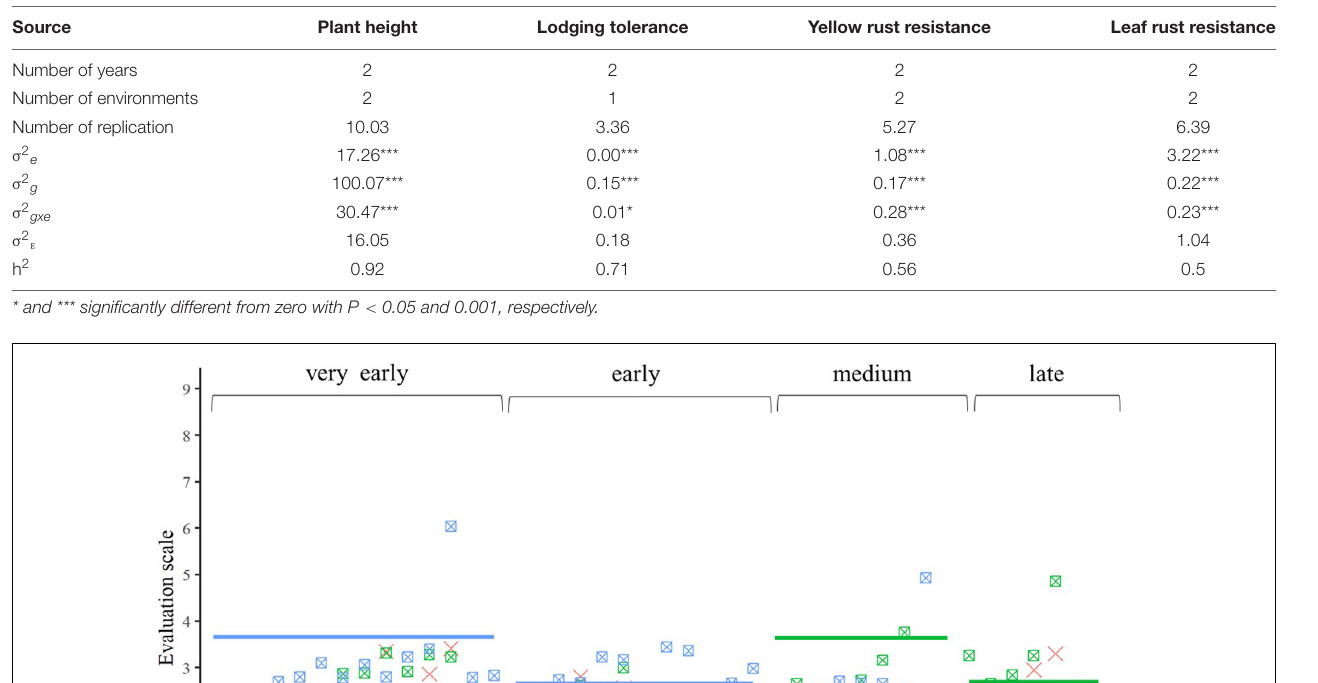
TABLE 4 | Variance components underlying phenotypic variation and broad-sense heritability (h 2 ) for the traits plant height, lodging tolerance, resistance to yellow rust and resistance to leaf rust of genotype ( σ 2 g ), environment ( σ 2 e ), the interaction between the genotype and environment ( σ 2 gxe ), and the residual ( σ 2 ε ) in the hybrid performance experiment.